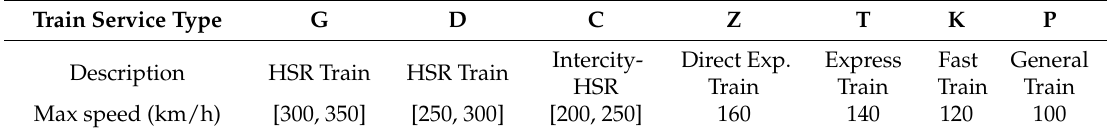
Table 2. Seven types of passenger train